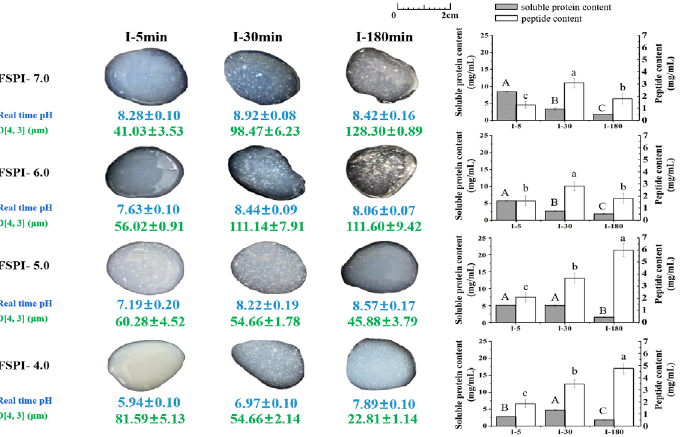
Figure 5. Intuitive images, D [4,3] value, real time pH, soluble protein, and peptide content of FSPI digestates collected during dynamic intestinal digestion. I-5, I-30, and I-180 denote intestinal digestion at 5 min, 30 min, and 180 min, respectively. Different letters indicate significant difference ( p < 0.05) between the FSPIs at different intestinal digestion stages.